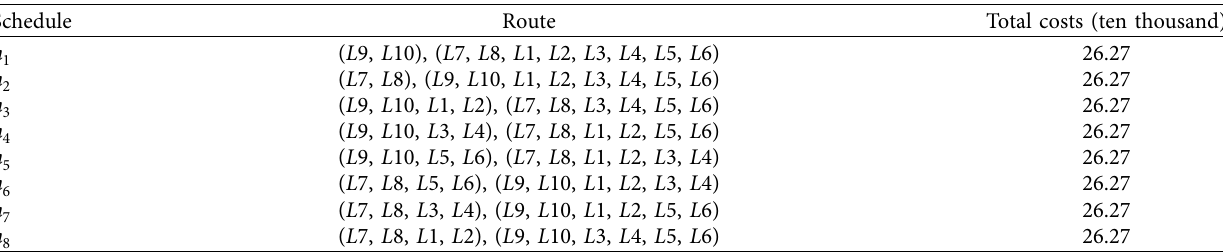
Table 2: Feasible